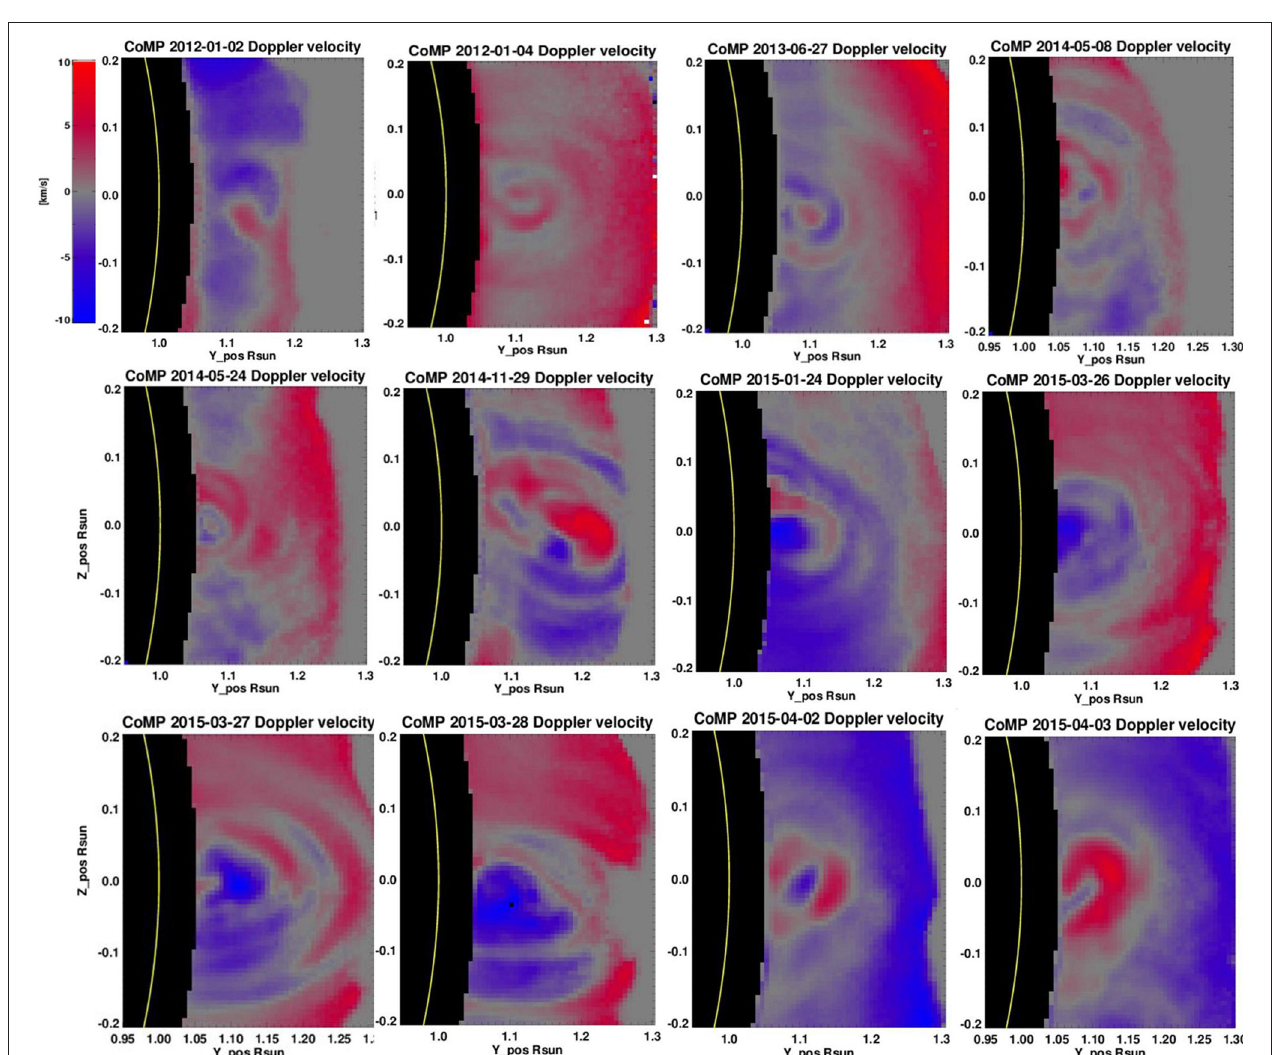
FIGURE 3 | Doppler velocity from CoMP observations for several